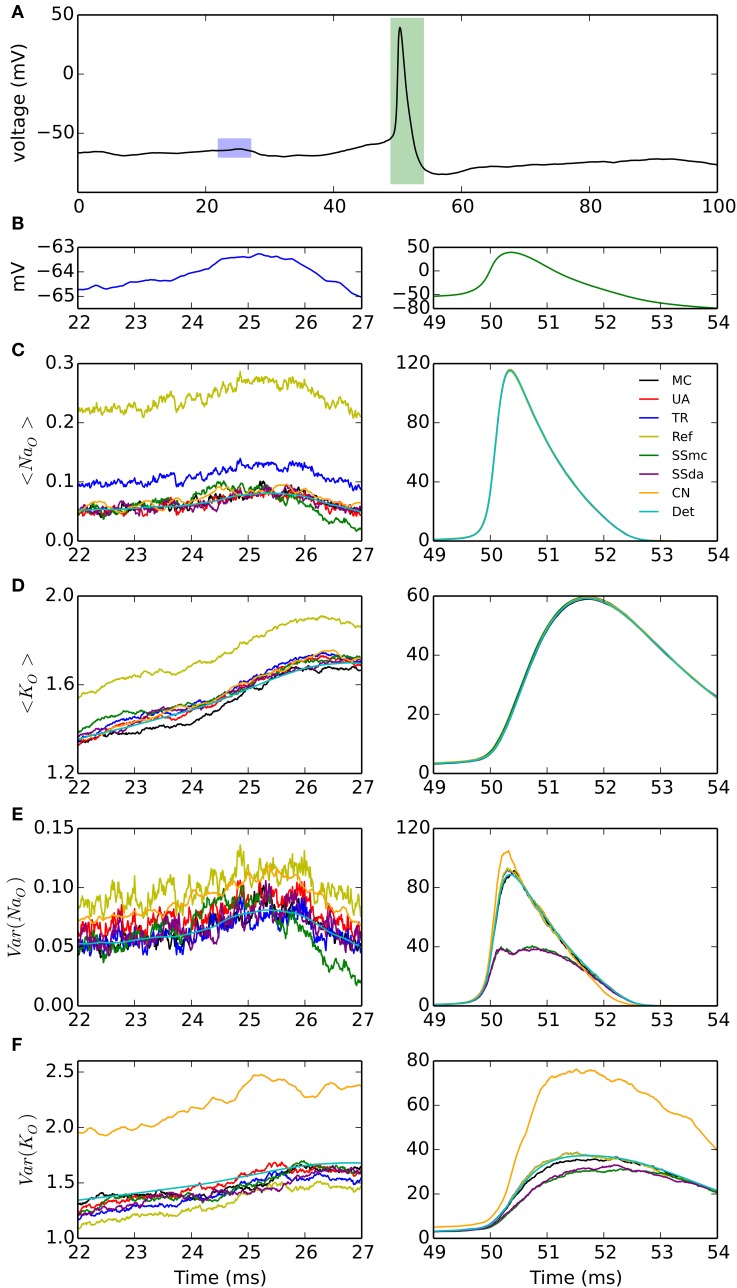
Simulations of the stochastic HH model under voltage clamp. (A) Voltage trace applied to simulated channels in a 100-ms simulation, repeated 2000 times. Blue and green rectangles represent the 5-ms intervals that are expanded in the left and right columns of the figure, respectively. (B) Detail of the voltage traces corresponding to the time windows analyzed in (C–F). Note the different vertical scales. (C) Mean of open sodium channels during the subthreshold (left) and action potential (right) regimes, for the simulation algorithms tested. (D) Mean of open potassium channels. (E) Variance of open sodium channels. (F) Variance of open potassium channels. NNa = 500, NK = 160. Very similar results were obtained with NNa = 5000, NK = 1600 (see text).